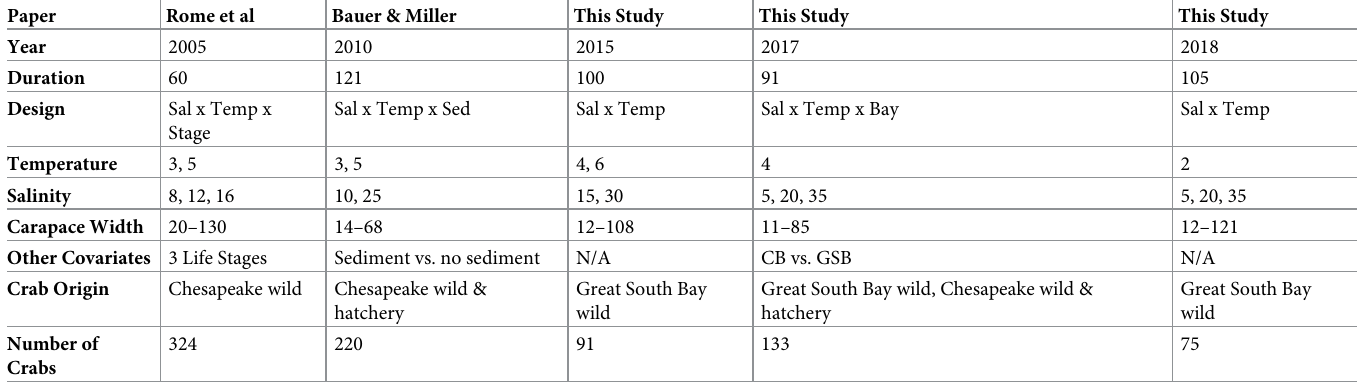
Table 1. Summary of all past and current blue crab winter mortality laboratory experiments. Units for temperature are in ˚C, salinity is in psu, duration is in days, and carapace width is in mm. The design indicates what covariates were used in the experiment. (Sal = salinity, Temp = temperature, Sed =